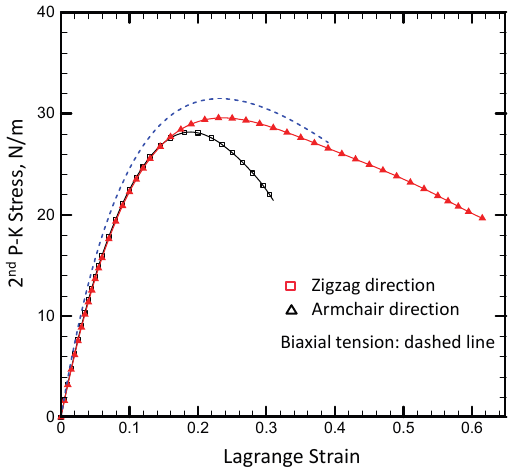
Figure 3. Relationship between the second P-K stress and Lagrange strain of graphene determined under uniaxial/biaxial stress tension.